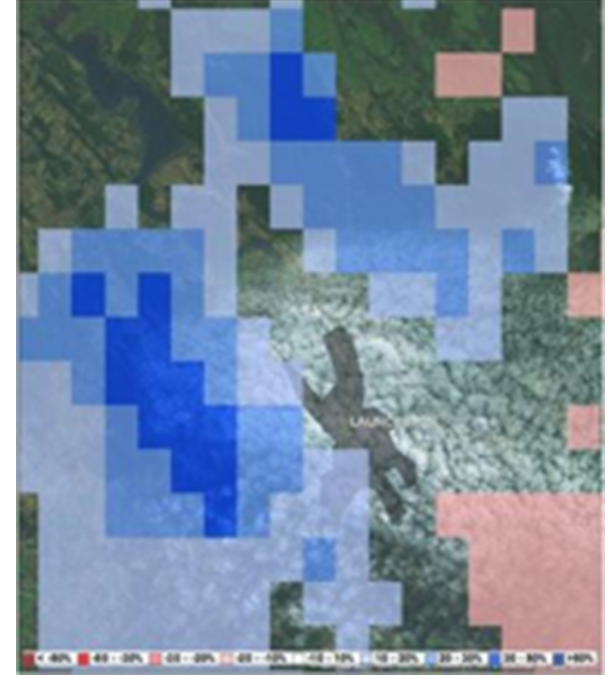
Figure 1. 72h, 50% AEP comparison mapping.